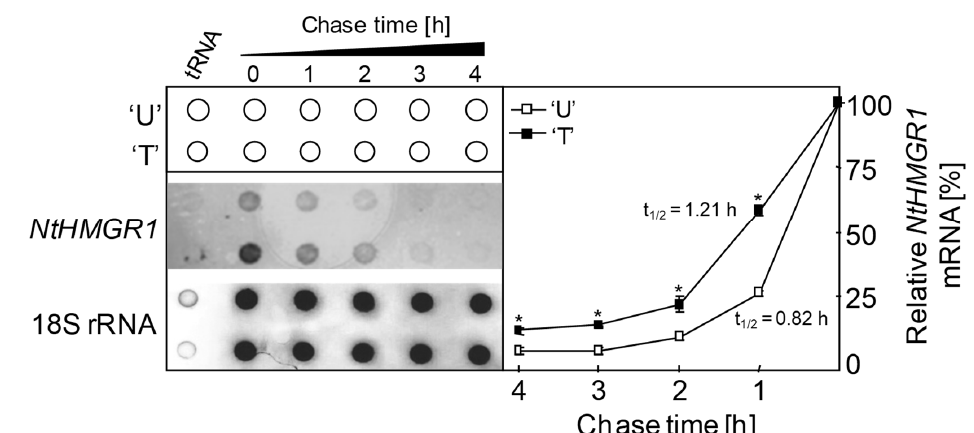
FigureFigureFigureFigure 5.5.5.5. Measurement of NtHMGR1 mRNA decay Post-addition of an optimized concentration (200 µg ml -1 ) of COR, an in vivo transcriptional-inhibitor, total RNAs was isolated from ‘U’ and ‘T’ at the indicated time of chases (0, 1, 2, 3 and 4 h) and thereafter subjected to dot-blot hybridization (~2 µg dot -1 ). The relative position of individual dot-blot and recognition of dotted RNA by hybridized α-[ 32 P]dATP-labelled DNA probes of NtHMGR1 and 18S rDNA are shown in upper -, middle - and bottom -panel, respectively ( left-panel ). The signal-intensity for hybridized NtHMGR1 transcripts from ‘U’ and ‘T’ at each time-point was quantified by densitometry-scanning and normalized to the corresponding constitutively expressed 18S rRNA. Normalized signal-intensity of NtHMGR1 transcript for ‘U’ and ‘T’ with respect to their corresponding time T 0 was plotted as line-graph and expressed in % ( right-panel ). NtHMGR1 mRNA t 1/2 was calculated by fitting non-linear regression. Means ± SDs, n = 2, * indicate the significant differences ( p ≤ 0.05 ). COR - Cordycepin, t 1/2 - half-life,